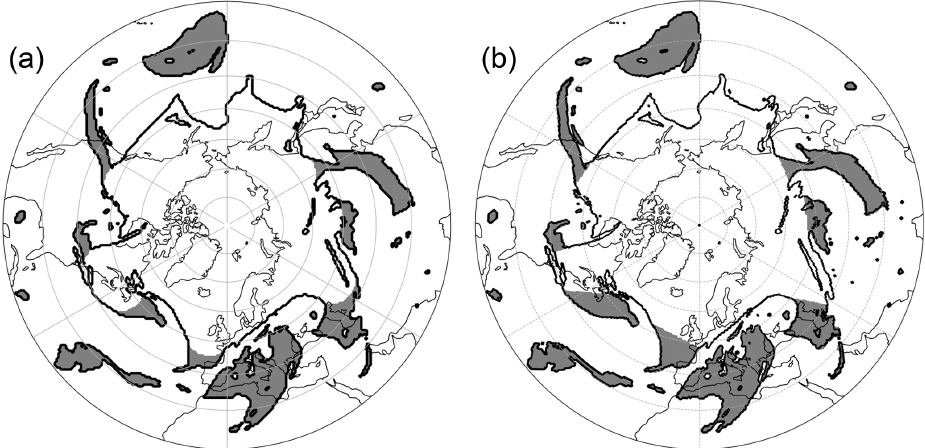
Figure 7. Comparison of the identified PVSs based on the 340K isentrope from the ERA5 data set on 24 July 2015, 00:00 UTC. (a) Results of our strategy using the default configuration and (b) by the algorithm from Wernli and Sprenger (2007). The anomaly over East Asia will be investigated in the case study later on.